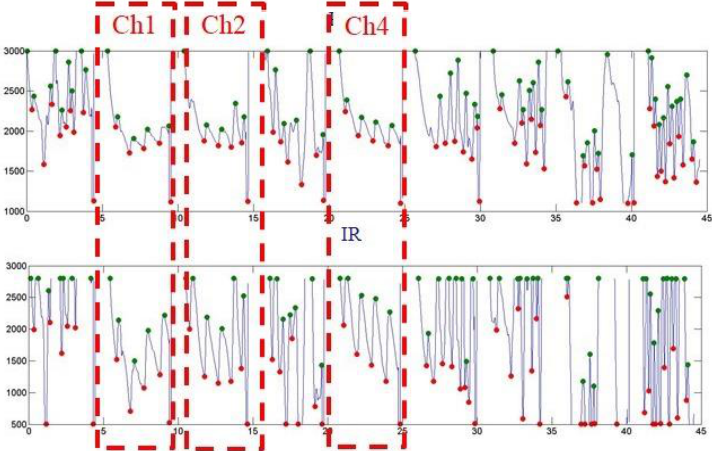
Figure 14. Dynamic state of the blood oxygen concentration value measurement results of a flexible blood oxygen sensing array with a pitch of 5 mm.